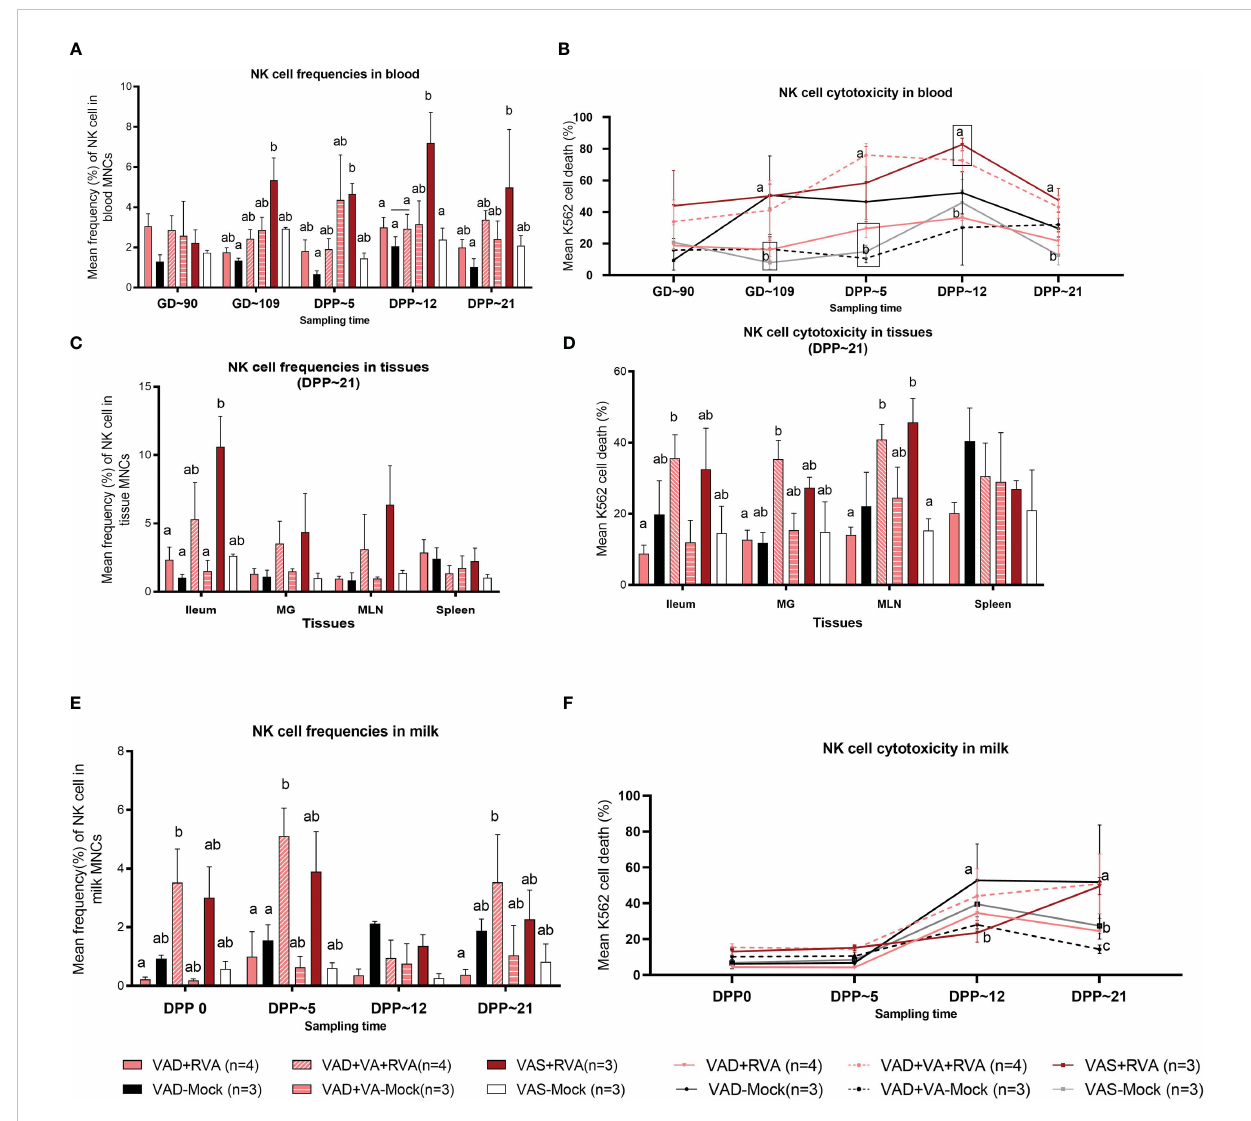
FIGURE 3 Natural killer (NK) cell frequencies and cytotoxicity analysis by fl ow cytometry. Sows were fed VAD or VAS diet from GD~30. A subset of VAD sows was given VA supplementation starting at GD~76 to the end of experiment. Blood, milk, and tissues were collected at GD~90 (blood), GD~109 (blood), DPP0 (milk), DPP~5 (milk &blood), DPP~12 (milk &blood) and DPP~21(milk, blood &tissues). Mononuclear cells were isolated and stained with porcine Abs against NK cell markers. (A) Mean frequencies of NK cells in blood. (C) Mean frequencies of NK cells in tissues (E) Mean frequencies of NK cells in milk. K562 cells were stained with CFSE and incubated with isolated mononuclear cells overnight. 7AAD was used to determine K562 cell death (CFSE + 7AAD + ) using fl ow cytometry. (B) NK cell activity (K562 cell death %) in blood (D) NK cell activity in tissues (F) NK cell activity in milk. Letters a and b indicate signi fi cant differences among treatment groups (mean ± SEM) at each time point. Statistical analysis was performed using two-way ANOVA with repeated measures and Tukey-Kramer test for multiple comparisons, P ≤ 0.05. (GD, gestation day; DPP, day post-partum; VAD, vitamin A de fi ciency; VAS, Vitamin A suf fi cient; VA-vitamin